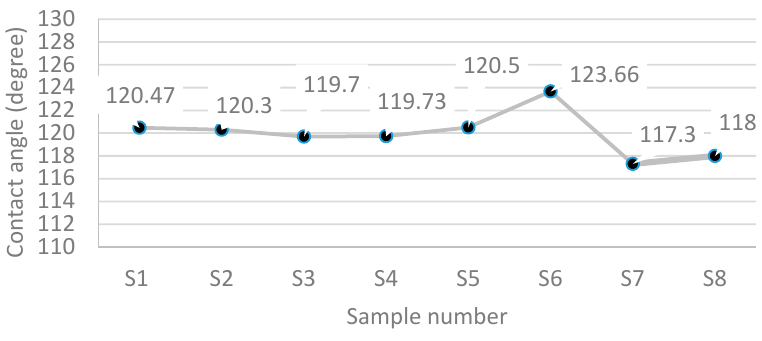
Figure 3. Contact angle values of samples S1–S8.